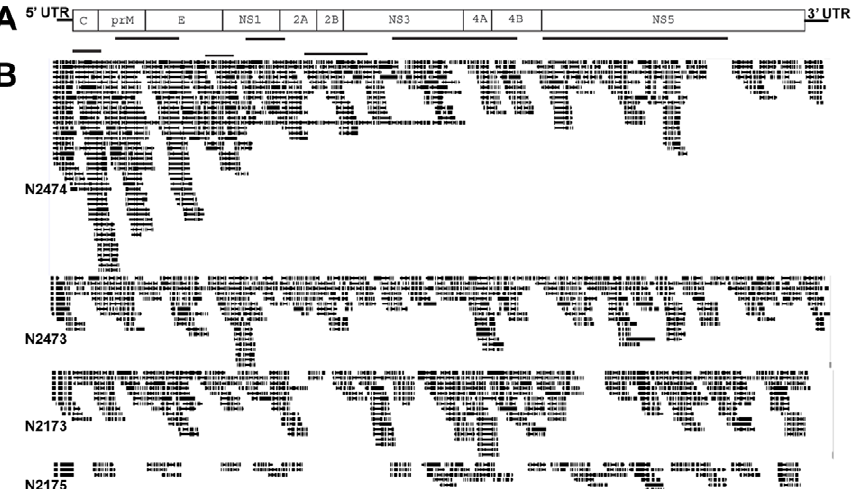
Figure 1. Coverage of Dengue genome. A) Reads resulting from sequencing library N2173 were assembled de novo using the Newbler Assembler (454/Roche) and then the 23 large contigs (greater than 500 nucleotides) were subjected to BLAST analysis to determine their best hits. The 7 Dengue-specific large contigs are shown here as horizontal lines below regions of the Dengue genome they correspond to. Scale is approximate. B) Reads resulting from sequencing of all 5 libraries were mapped to the DENV-1 genome using GS Reference Mapper (454/Roche) and then viewed using Geneious software. The control noninfected mosquito dataset had no reads that mapped to the DENV-1 genome and therefore is not shown here.